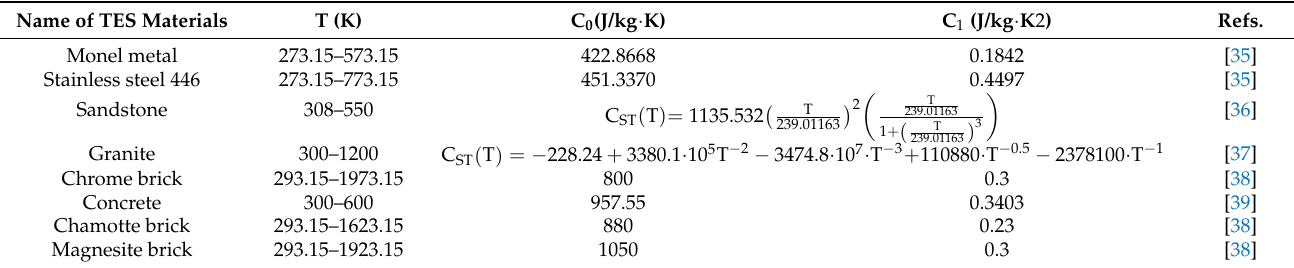
Table 5. Selected TES materials and its